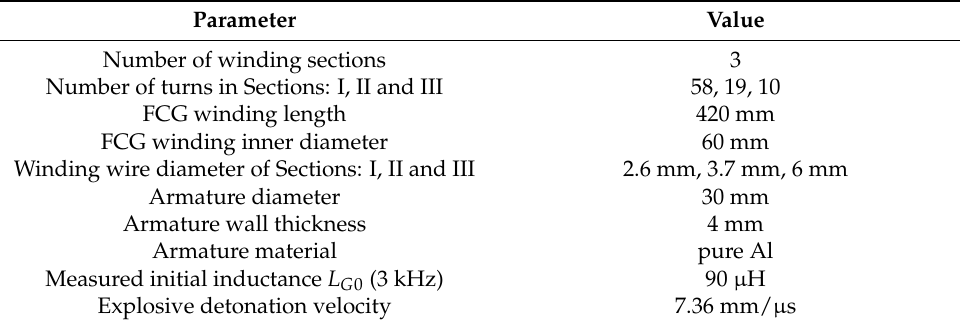
Number of turns in Sections: I, II and